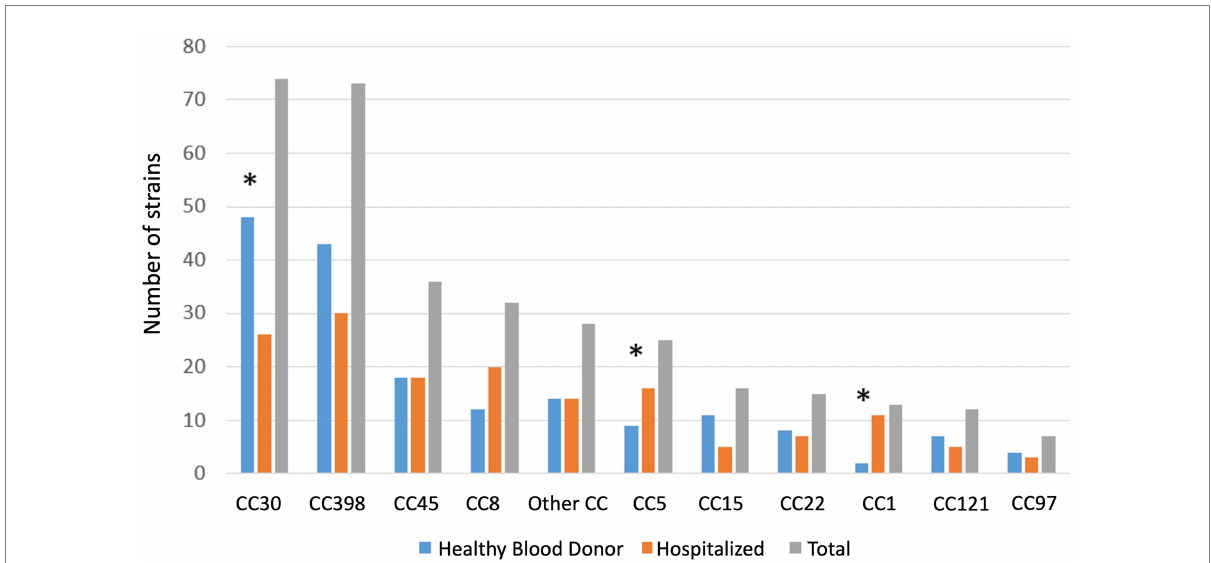
FIGURE 1 Distribution of Staphylococcus aureus clonal complex in hospitalized patients and healthy blood donor. Other: CC7 ( n = 5), CC182 ( n = 3), CC1640 ( n = 2), CC59 ( n = 3), CC20 ( n = 2), unknown ( n = 3), CC10, CC12, CC80, CC88, CC101, CC152, CC395, CC707, CC3803, CC106, (one each). * p <